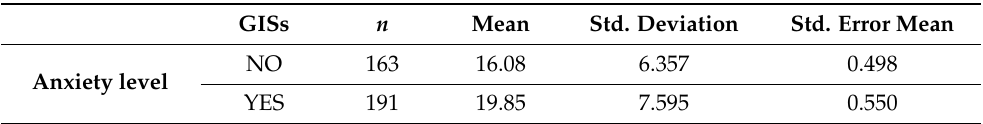
Table 4. Correlation between anxiety level and presence of GISs during the lockdown: group statistics; see Table 5 for statistical significance.